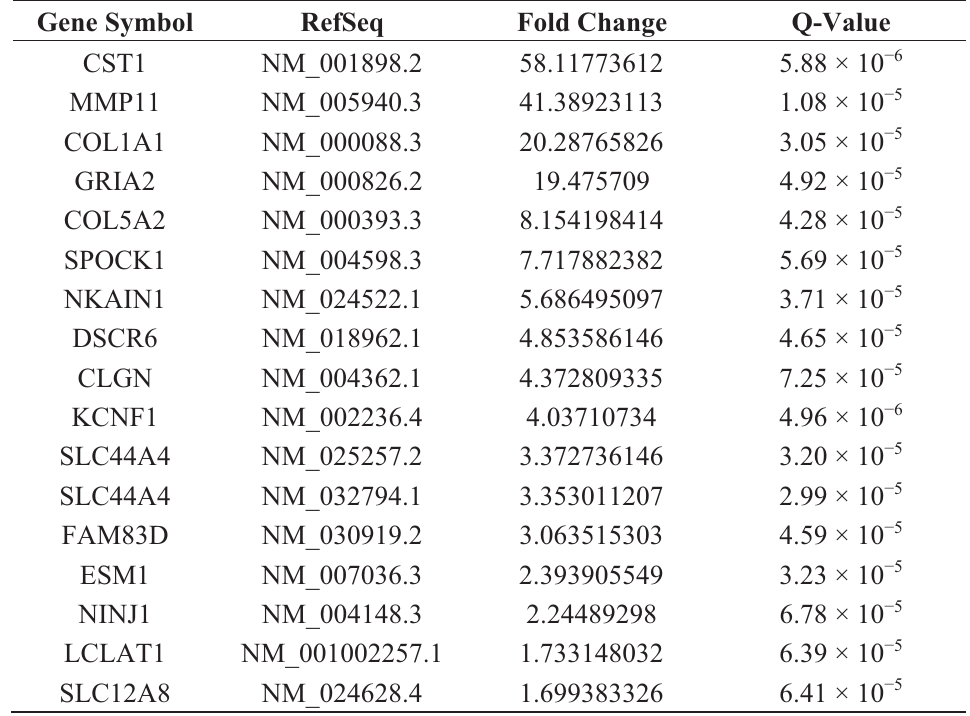
Table 3. List of genes upregulated in the breast cancer group compared with normal breast tissues.